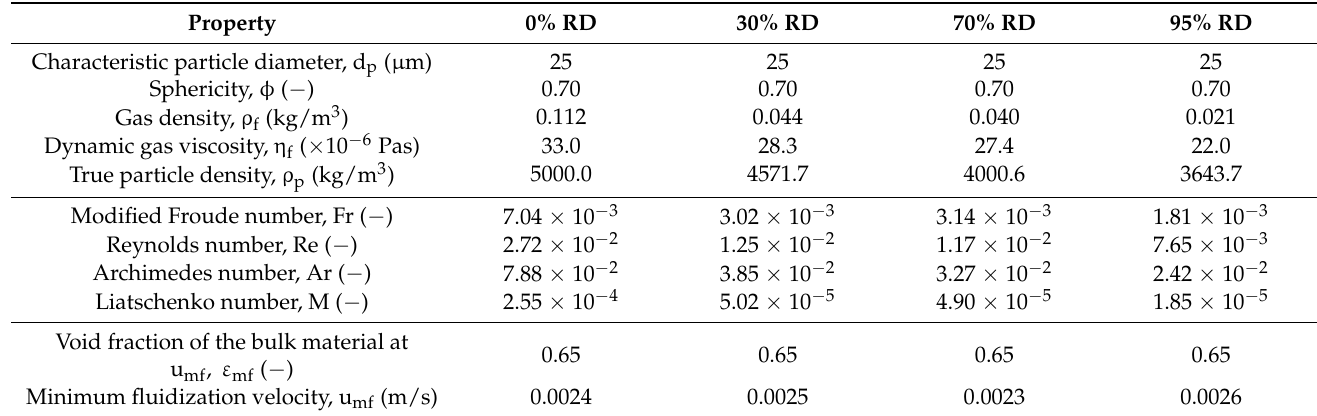
Table A1. Changing gas and bed material properties, dimensionless numbers, and minimum flu- idization velocity for reduction at 873 K.